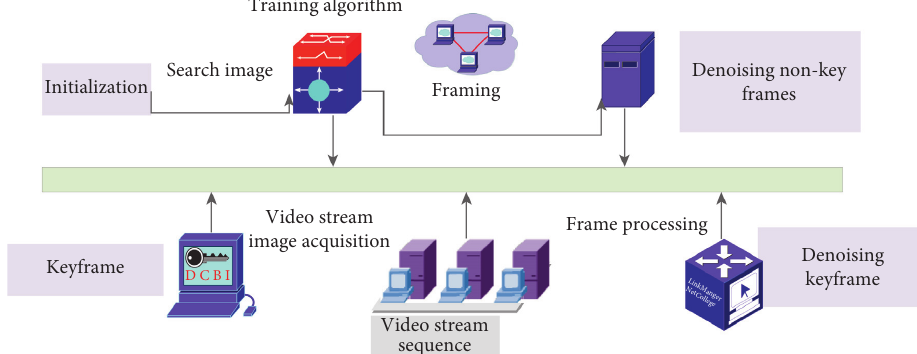
Figure 1: Structure of the general intelligent guided learning system